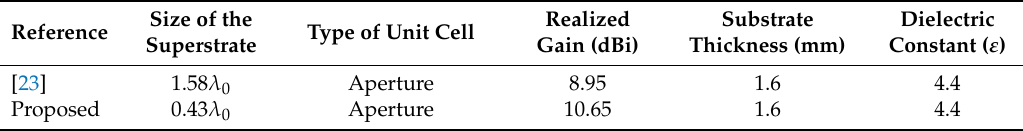
Figure 8. Reflection, transmission, and phase characteristics of the unit cell. Table 2. Comparison of the proposed superstrate with existing